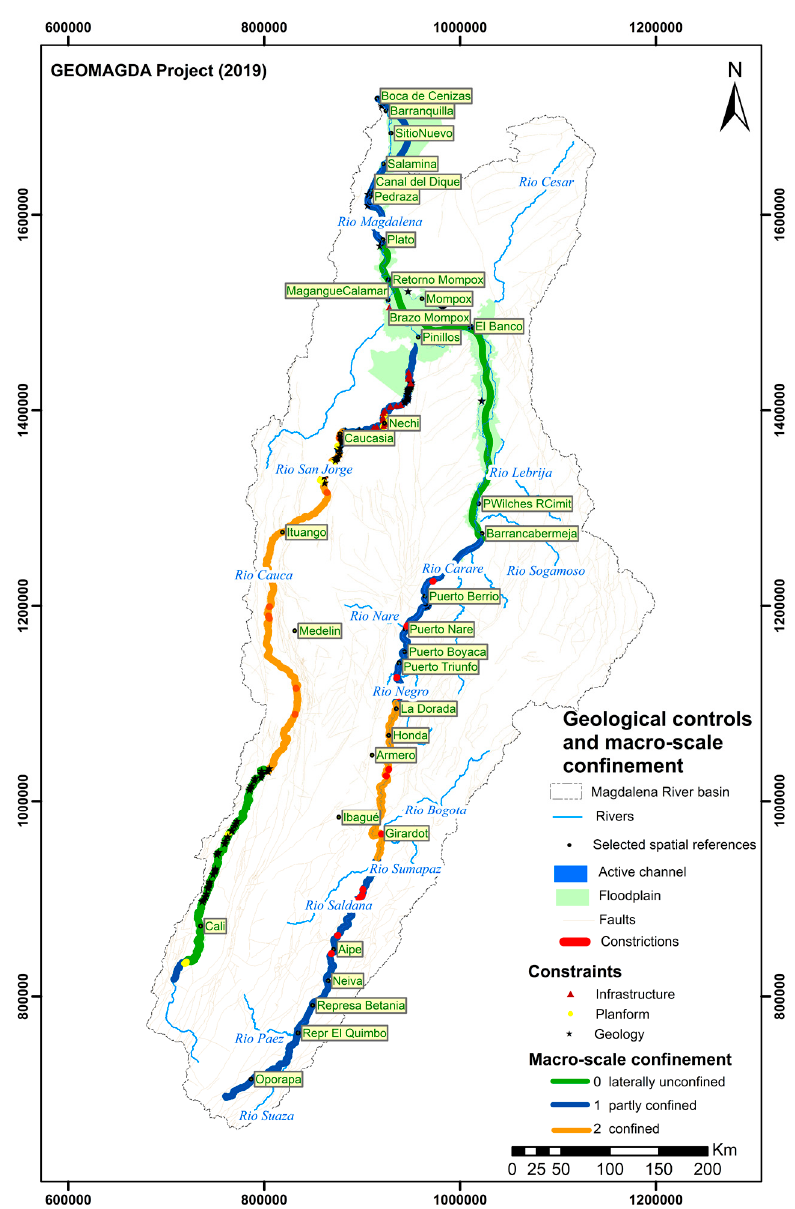
Figure 3. Map of the Magdalena basin highlighting some of the tectonic controls and the macro-scale confinement.